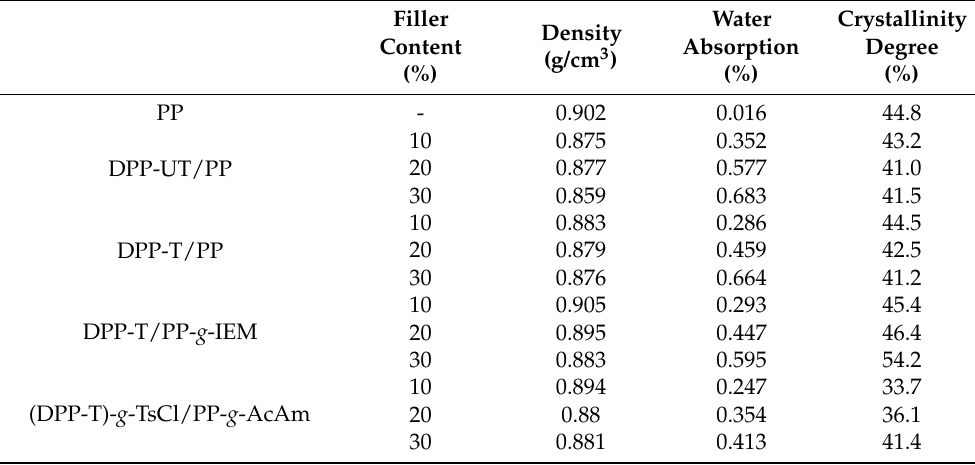
Table 2. Summary of the physical properties of the developed